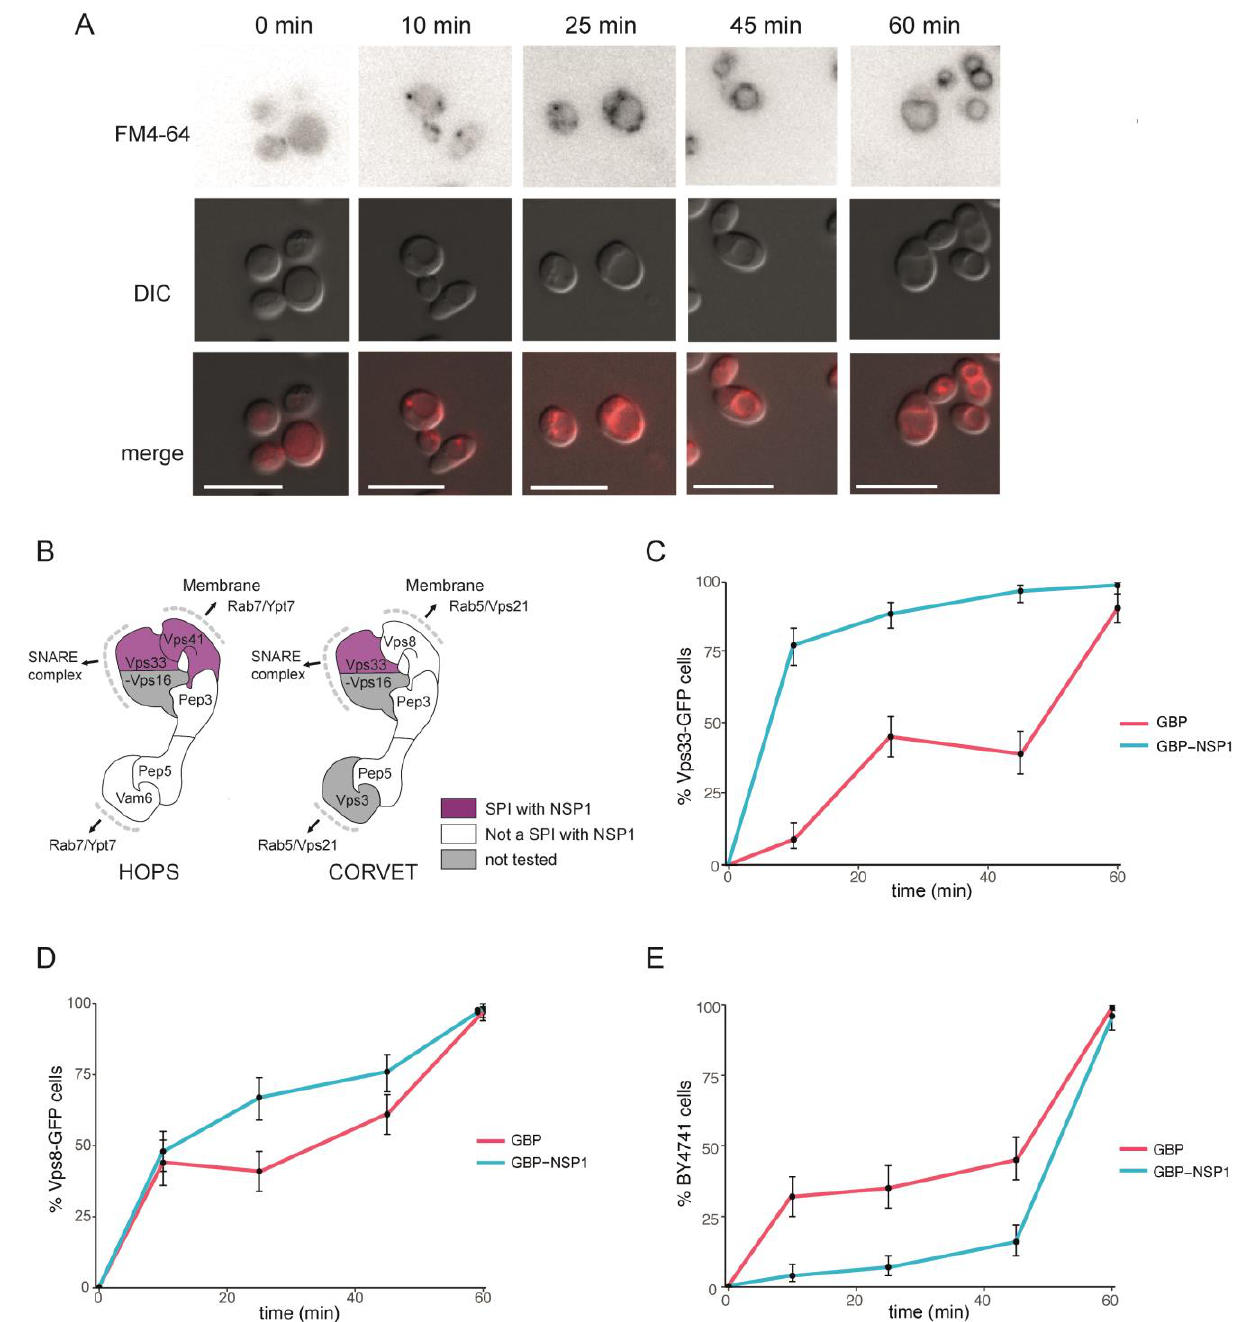
FIGURE 6: Effect of NSP1 SPI at the HOPS complex. (A) Uptake of FM4-64 dye to the vacuolar membrane. BY4741 cells were grown in medi- um containing 4 nM FM4-64 and images taken every 10-20 minutes. The progression of the dye to the vacuolar membrane is clear within 60 minutes. The scale bar is 10 µm. (B) HOPS and CORVET complexes are illustrated based on electron microscopy 3D reconstruction [28] and functional domains [68]. Vps33 and Vps41 were identified as SPIs in the NSP1 screen and are highlighted in purple accordingly. (C) Following a 90-minute induction of GBP or NSP1-GBP expression in a Vps33-GFP strain, FM4-64 was added, and vacuolar staining of cells was quantified at 10, 25, 45 and 60 minutes from dye addition. Error bars indicate 95% binomial confidence intervals. (D) The experiment is as in panel C, but using a Vps8-GFP strain. (E) The data is as in panel C, but with a strain that lacks any GFP,